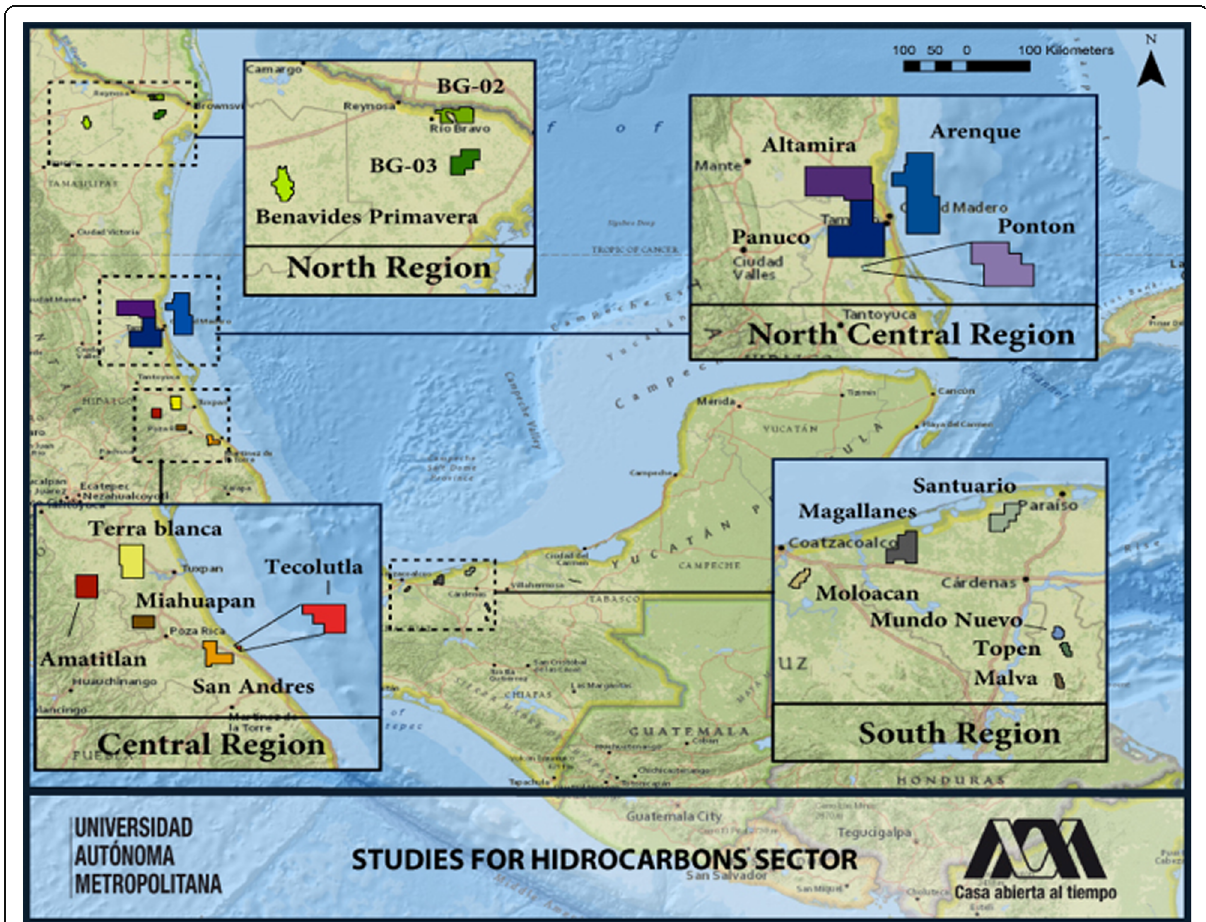
Fig. 1 Oil blocks where the UAMI ’ s team has been working. Elaborated by Paul Fabre for UAMI's Team,